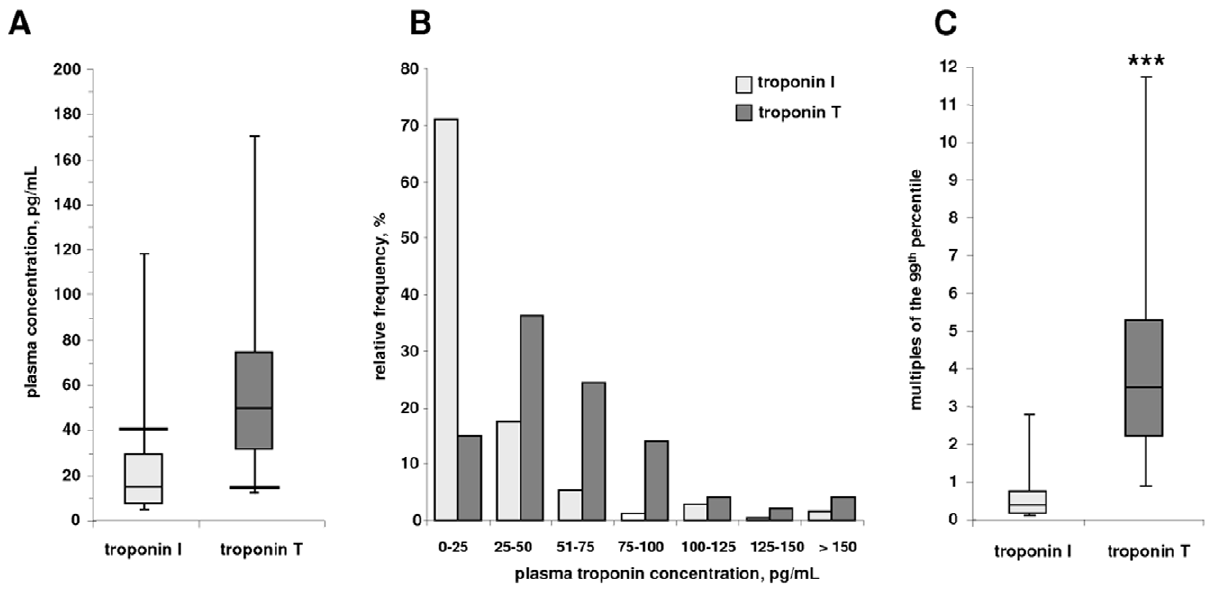
Figure 1. Depiction of the plasma troponin I and T concentrations in the cohort. A Box-and-Whiskers-Plot of the plasma troponin I and T concentrations indicating the median, interquartile range and the range between the 2.5 th and 97.5 th percentile. Solid lines represent the 99 th percentile of the assay [19]. B Distribution of the plasma troponin I and T concentrations in the cohort (n=239). C Box-and-Whiskers-Plot of the plasma troponin I and T concentrations expressed as multiples of the 99 th percentile [19]. *** indicates a significant difference (p , 0.0001) between the troponin T and troponin I concentrations.